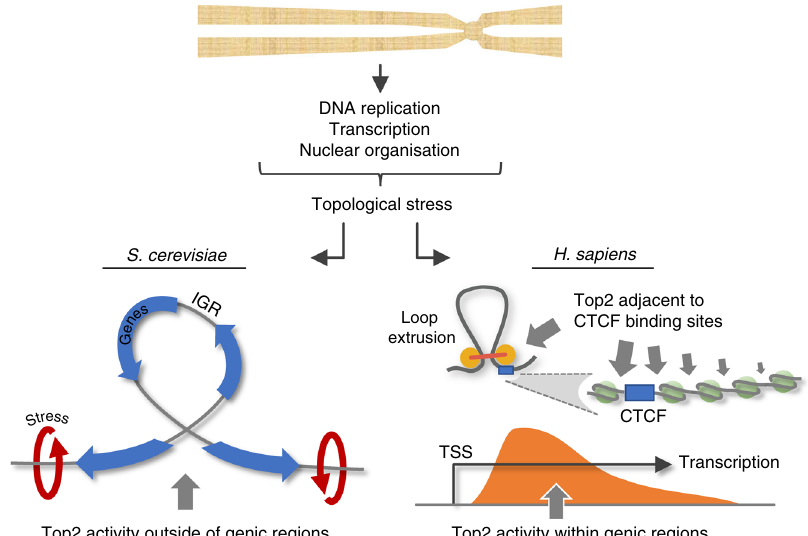
Fig. 7 Comparison of Top2 activity in S . cerevisiae and human cells. Topological stress arising within chromosomes is primarily resolved by Top2 in IGRs in the compact S . cerevisiae genome. By contrast, in human cells, TOP2 activity is located around the binding sites of CTCF — a nuclear organising factor that both patterns cohesin dependent loop extrusion and causes local nucleosomal ordering — and also preferentially towards the 5 ′ end of genes, where it correlates with local transcriptional